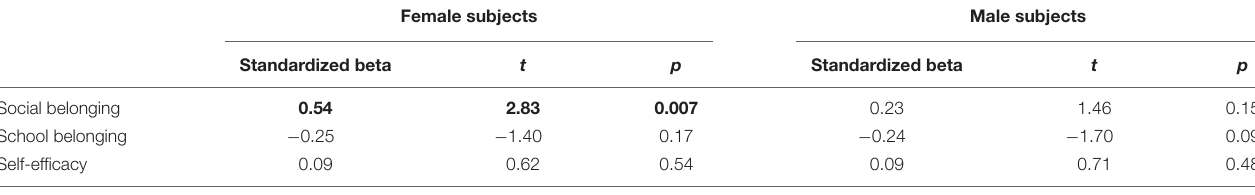
TABLE 4 | Social belonging, school belonging, and self-efficacy predicting intentions to persist in pSTEM.